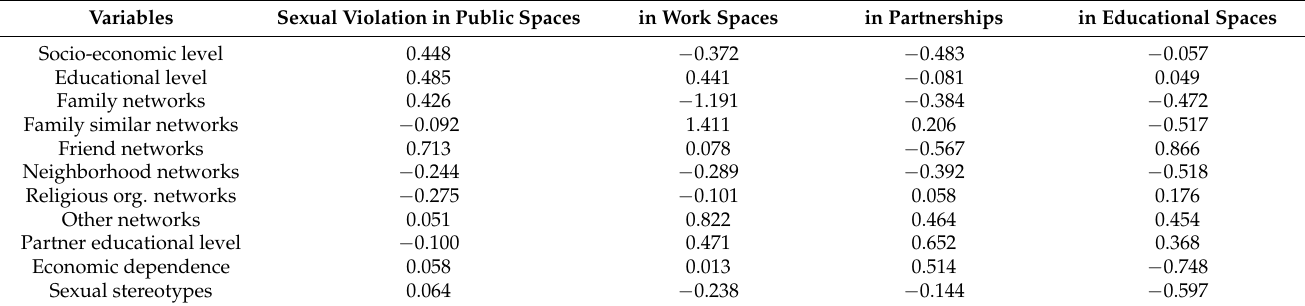
Table 4. Average coefficients between factors (types of capital) and areas of sexual violence.